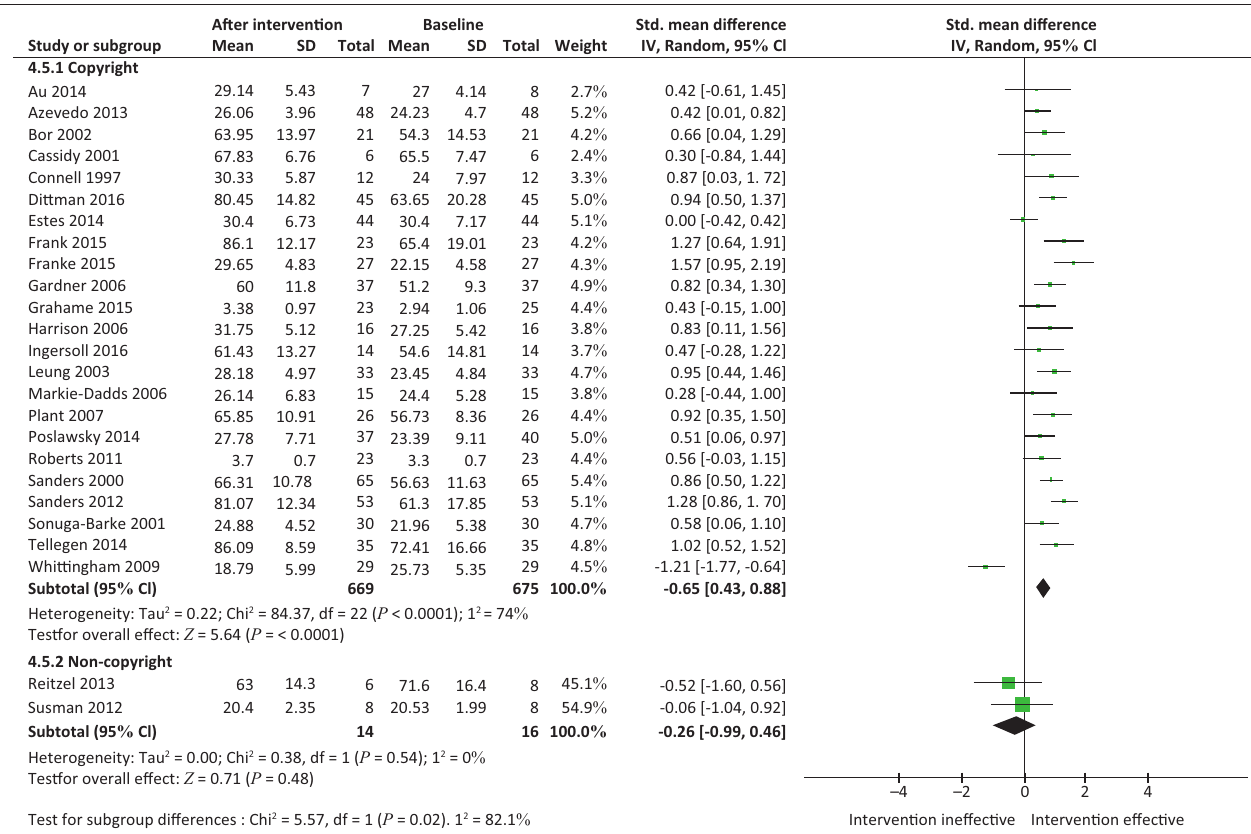
ClStd. mean difference IV, Random, 95 % ClStudy or subgroup